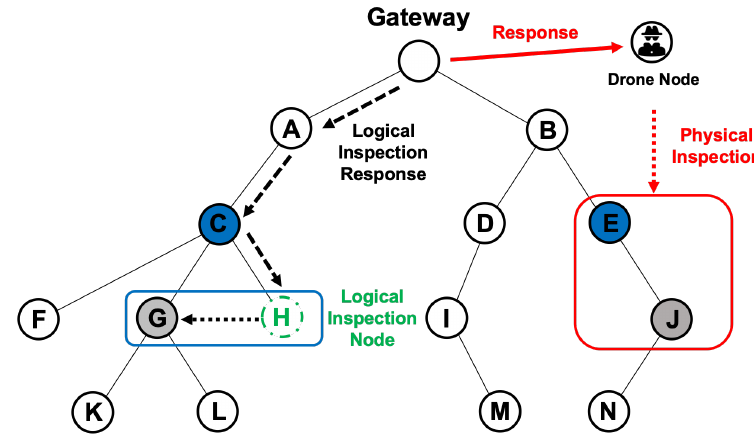
Figure 6. Example of the Trust evaluation phase with logical and physical